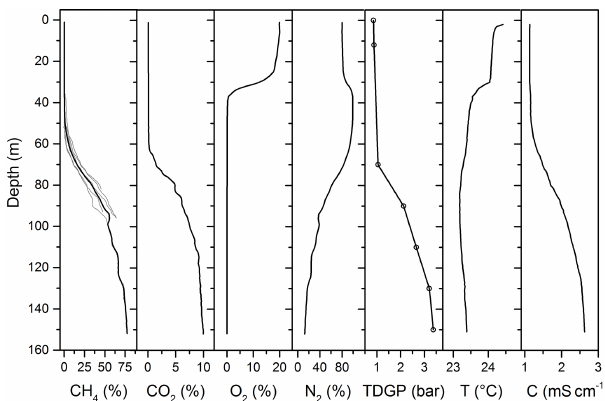
Figure 5. Mixing ratios of individual gas species in the dissolved gas mixture and total dissolved gas pressure. Grey CH 4 lines rep- resent the eight profiles recorded by the Sub-Ocean instrument dur- ing the campaign, while the black line is the averaged value. CO 2 data are from Schmid et al. (2005); O 2 , temperature and electri- cal conductivity are from CTD data during the campaign; and N 2 is a concentration profile deduced from the other measurements (TDGP − p CH 4 − p CO 2 − p O 2 ). The total dissolve gas pressure, TDGP, was measured using the Contros HydroC ® HP sensor (open circles); the black line is an interpolation of the data.